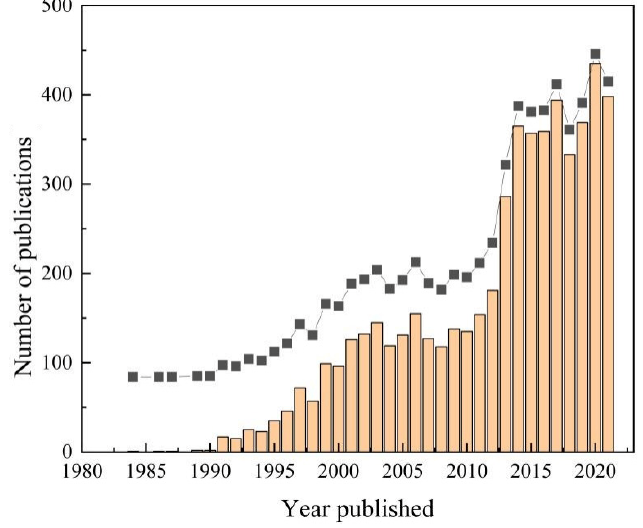
Figure 1. The number of waste lithium-ion battery recycling articles and the cumulative percentage of articles issued.